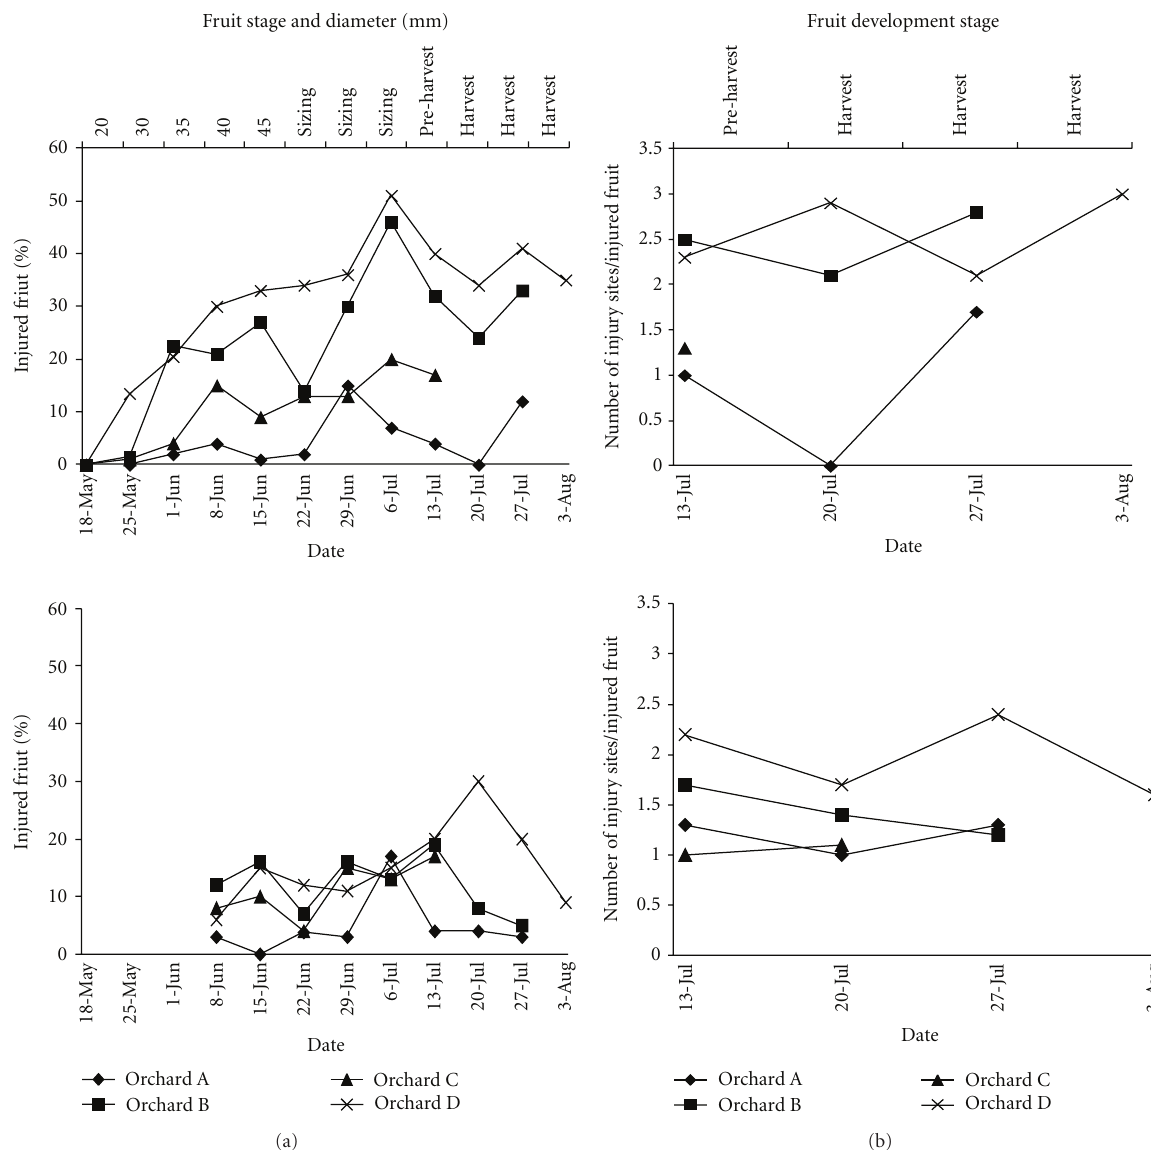
Figure 9: (a) Percent injured peaches in 2011 at orchards A–D from the plot exterior (top) and interior (bottom) and (b) the number of injury sites per injured fruit in 2011 at orchards A–D in the plot exterior (top) and interior (bottom).